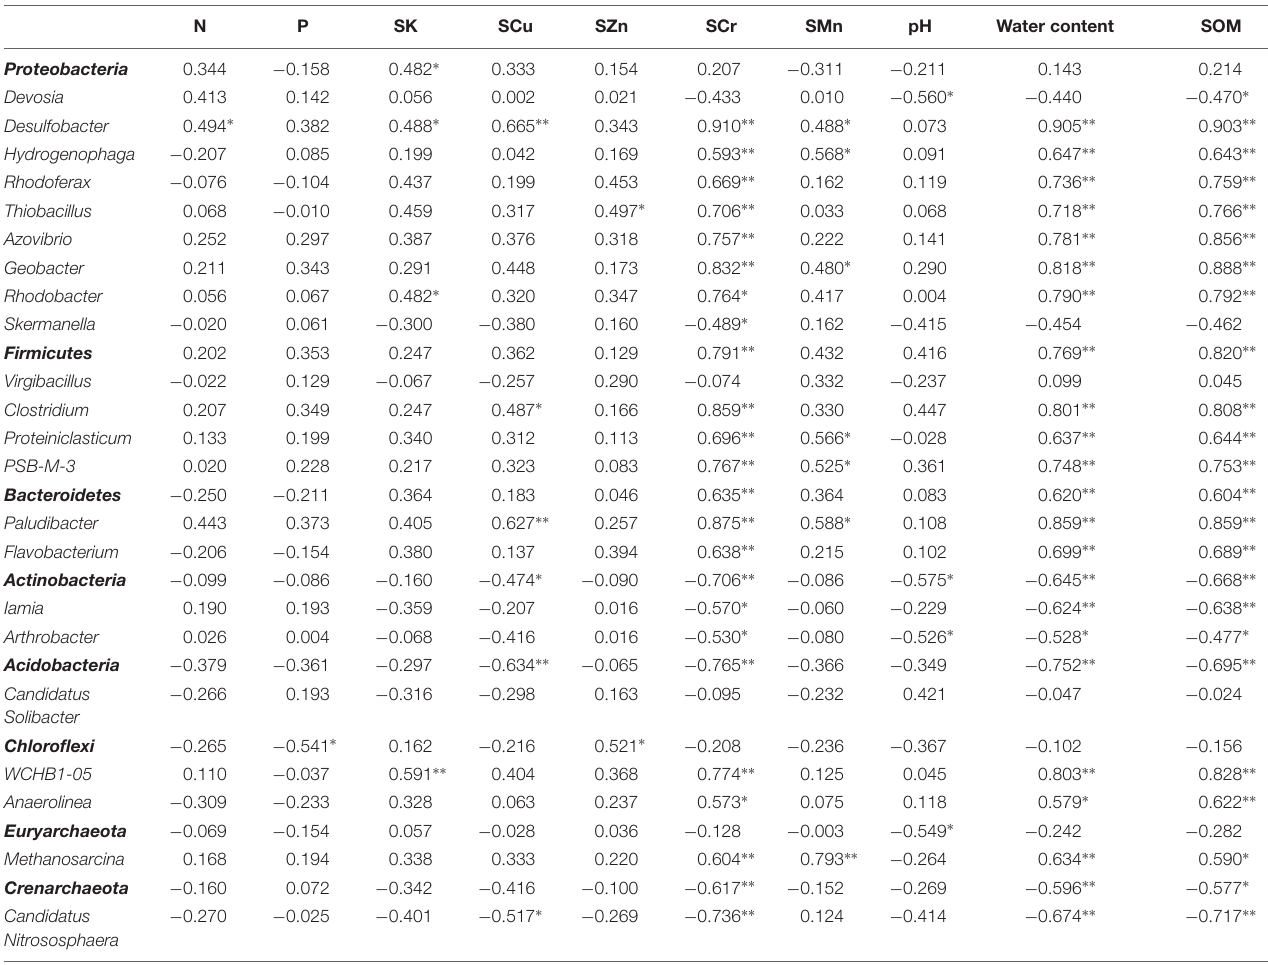
TABLE 3 | Spearman’s correlation coefficients between the relative abundance of the dominant microbes (at phylum and genus level, respectively) and environmental variables. N P SK SCu SZn SCr SMn pH Water